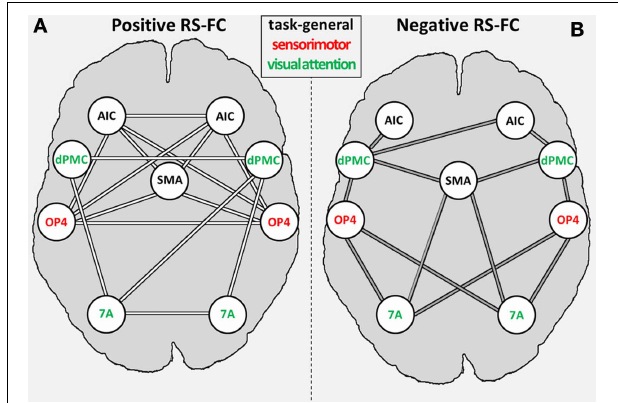
FIGURE 4 | General positive (A) and negative (B) inter-regional resting-state functional connectivity (RS-FC) for the combined set of seed regions. Regions labeled in green are associated with the visual attention system; regions labeled in red are associated with the sensorimotor system [as indicated by the previous fMRI study (OP4, dPMC, and 7A; Roski et al., 2013)]; regions labeled in gray have no functional preference (i.e., task-general regions). 7A, superior parietal lobule area 7A; AIC, anterior insular cortex; dPMC, dorsal premotor cortex; OP4, area OP4 of the parietal operculum; SMAr, rostroventral supplementary motor cortex.